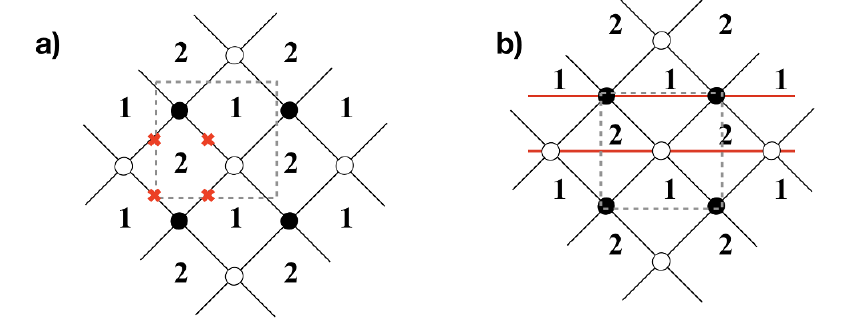
Figure 4 . Dimer diagrams for orientifolds of the conifold with (cid:12)xed points (a) or (cid:12)xed lines